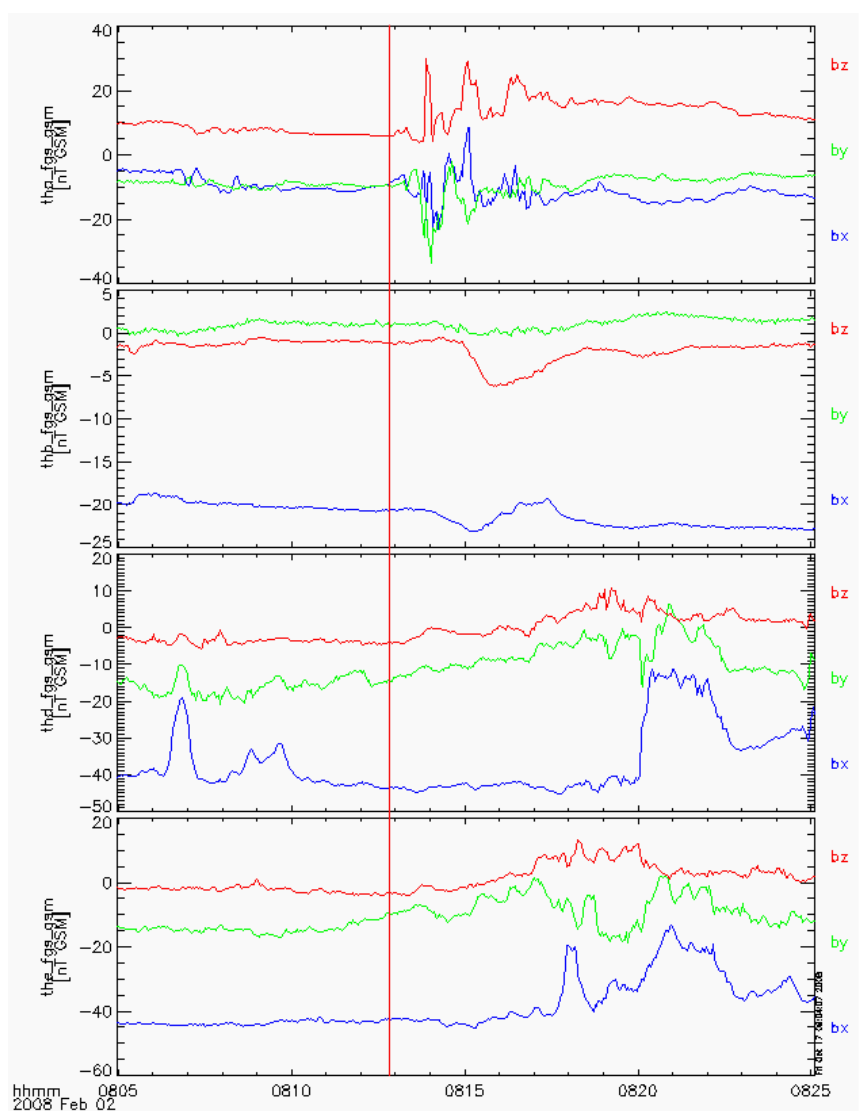
Fig. 14. Satellite flux gate magnetometer data. The red vertical denotes the nominal onset of the poleward expansion (SPE) at 08:12:48. The onset of the magnetic variation attributable to this substorm started at 08:13:21 for THEMISA, 08:14:50 for THEMIS B and at ∼ 08:17:00 for THEMIS D and E.